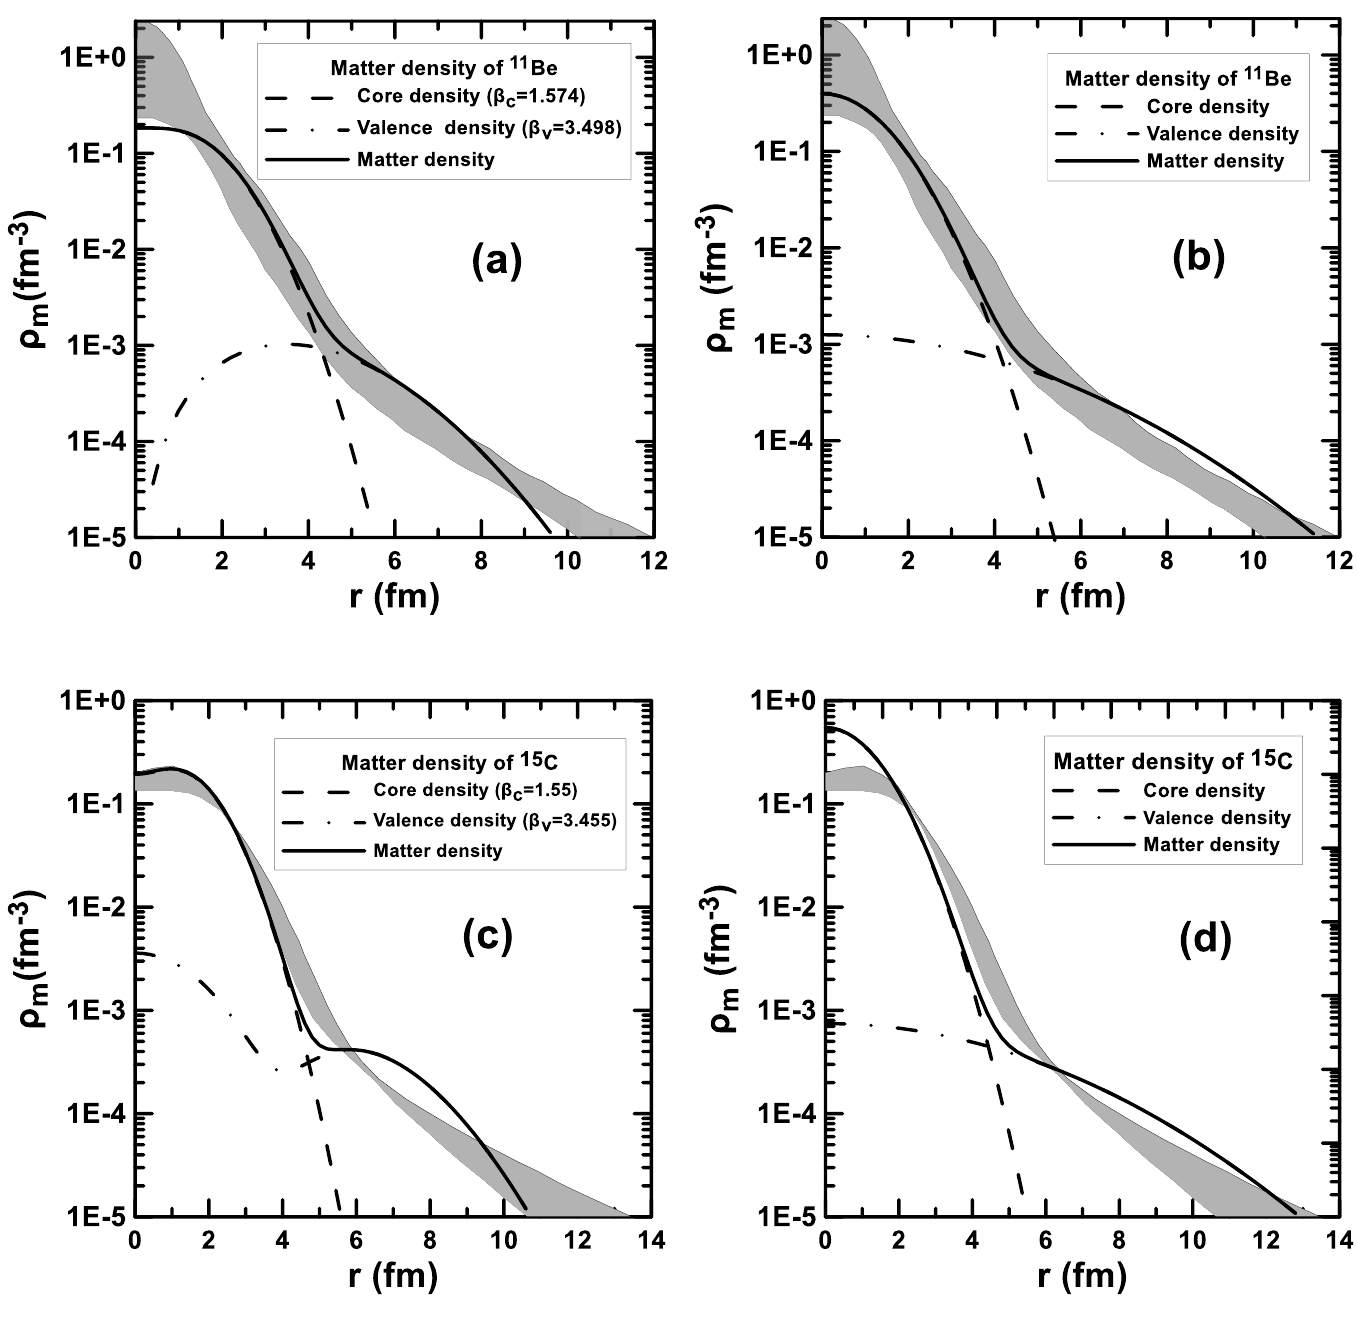
Fig.2: The calculated matter density distributions obtained via TFSM [Figs. (a) and (c)] and BCM [Figs. (b) and (d)]. The top and bottom panels correspond to halo nuclei Be 11 and , 15 C respectively. The shaded area shows the experimental matter density distribution of 11 Be [43] and 15 C